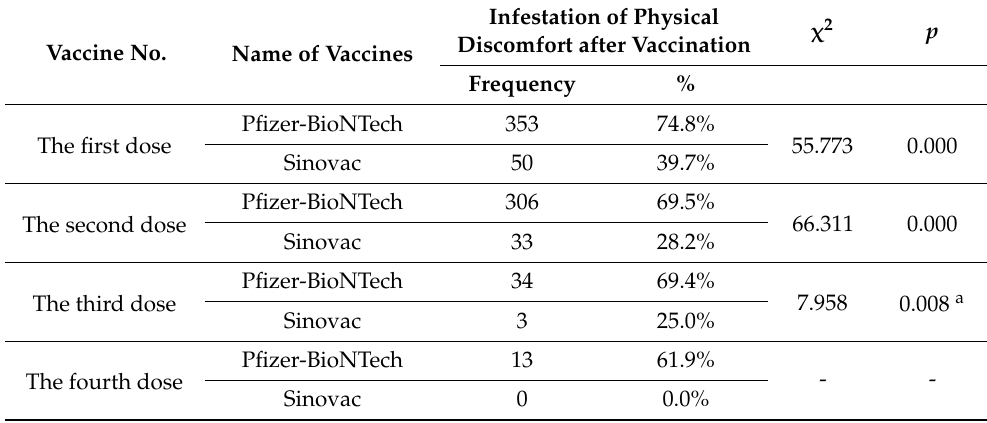
Table 4. Comparison of physical discomfort experienced after being